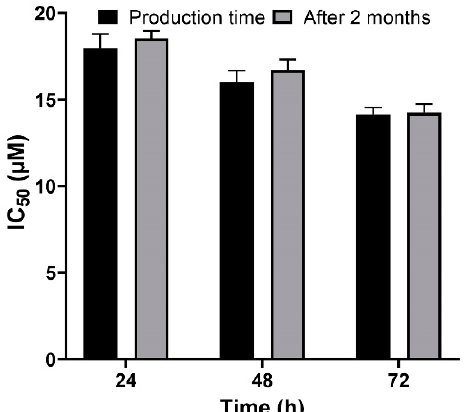
Figure 9. Evaluation of the cytotoxicity effects of cisplatin-loaded PBCA nanoparticles in the production time compared to two months after the synthesis. The data were expressed as mean ± SD (n = 3).